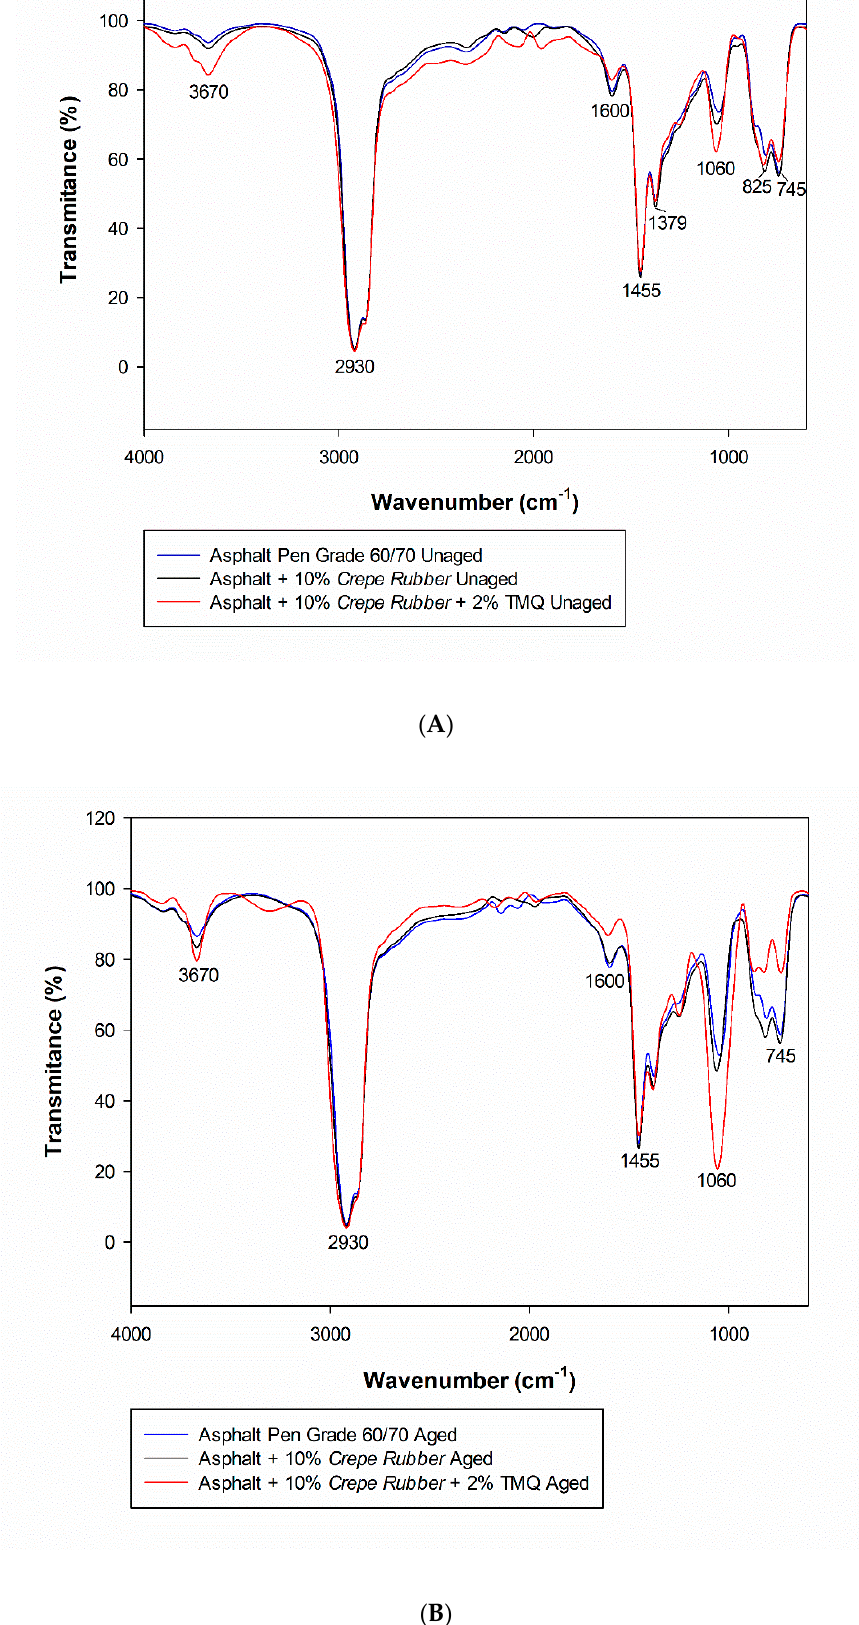
Figure 12. ( A ) FT-IR of asphalt before LTOA. ( B ) FT-IR asphalt after